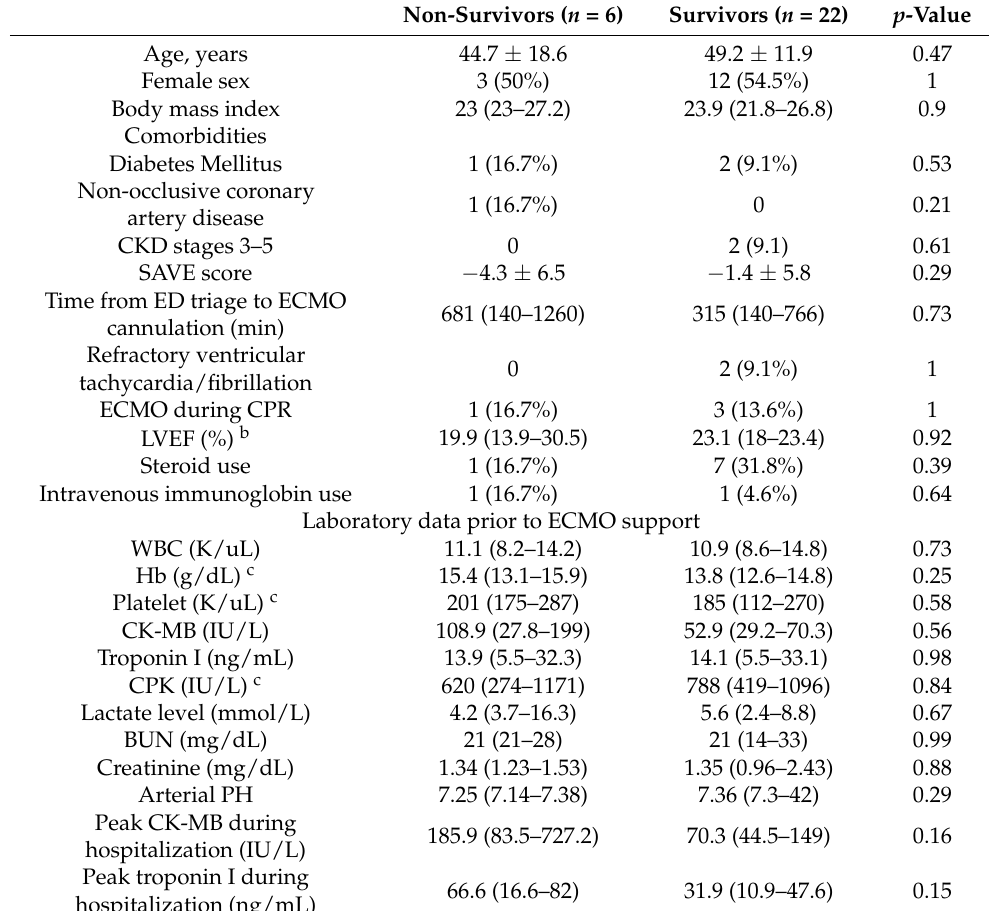
Table 1. Patient characteristics, SAVE score, LVEF, steroid/IVIG use, and laboratory data at baseline a